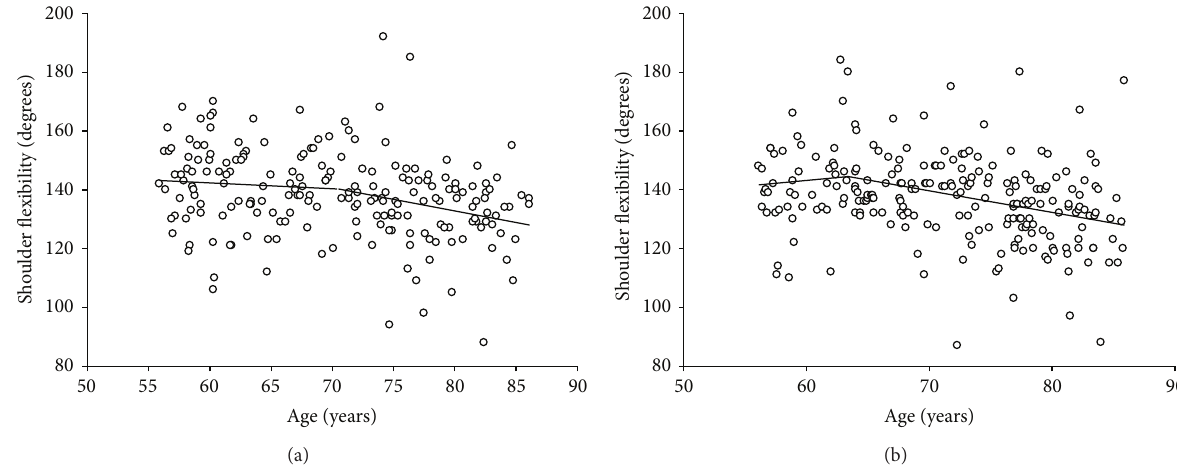
Figure 1: (a) Age analysis for shoulder flexibility in men. Piecewise linear regression s-segment model shows breaking at the age of 71 years. Rate of decline prior to age 71 is − 0.20 degrees per year and − 0.80 degrees per year after the age of 71 years. ( 𝑅 2 of fit 𝑅 2 = 0.09 ). (b) Age analysis for shoulder flexibility in women. Piecewise linear regression s-segment model shows breaking at the age of 63 years. Rate of change prior to age 63 is 0.38 degrees per year and − 0.74 degrees per year after the age of 63 years. ( 𝑅 2 of fit 𝑅 2 = 0.09 ).